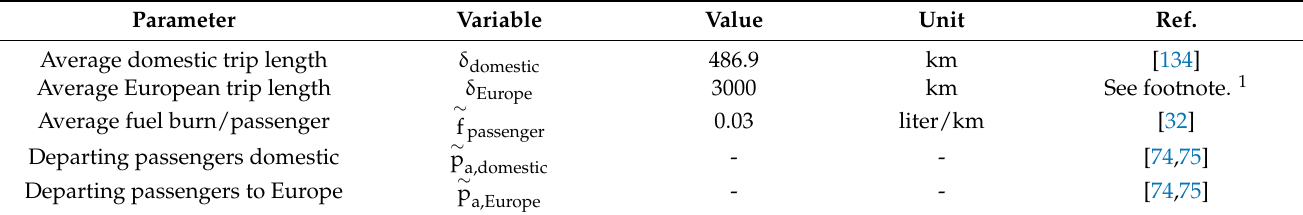
Table 7. Parameters used to calculate fuel demand for small Swedish